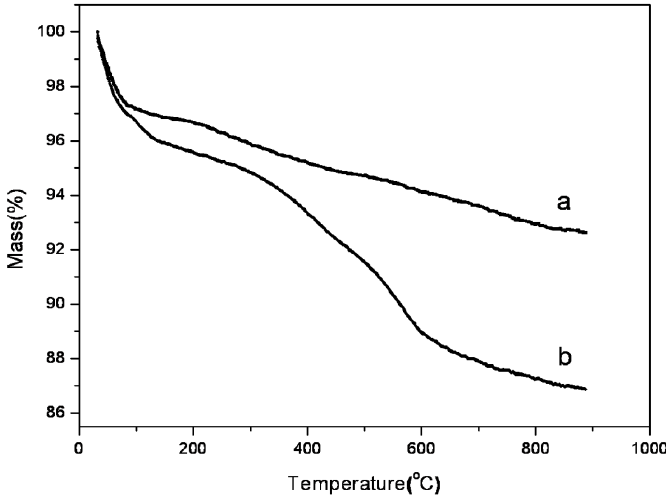
* The silanol density (ρ) was calculated as: ρ(mmol/g) = losses due to the dehydroxylation by condensation of silanols;